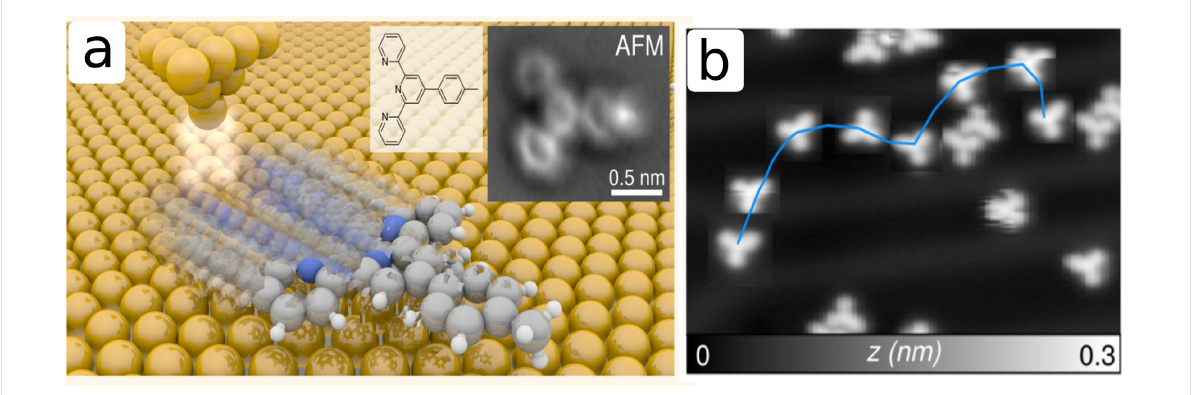
Figure 8: The “Swiss Nanodragster” (SND), a 4’-( p -tolyl)-2,2’:6’,2”-terpyridine molecule, was moved across an Au(111) surface on the occasion of the first nanocar race held in Toulouse in April 2017. The required distance of 100 nm of controlled motion was covered through the application of voltage pulses. a) Schematics of the manipulation of the molecule. Left inset: Structure of the SND molecule. Right inset: High-resolution AFM image of the SND molecule. b) A sequence of manipulation steps, as observed by STM imaging between the manipulation steps. Reprinted with permission